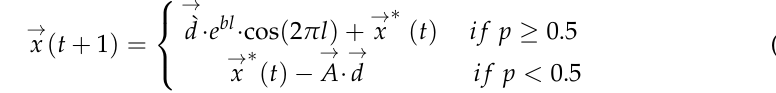
Figure 4. Bubble-net searching mechanism [37].